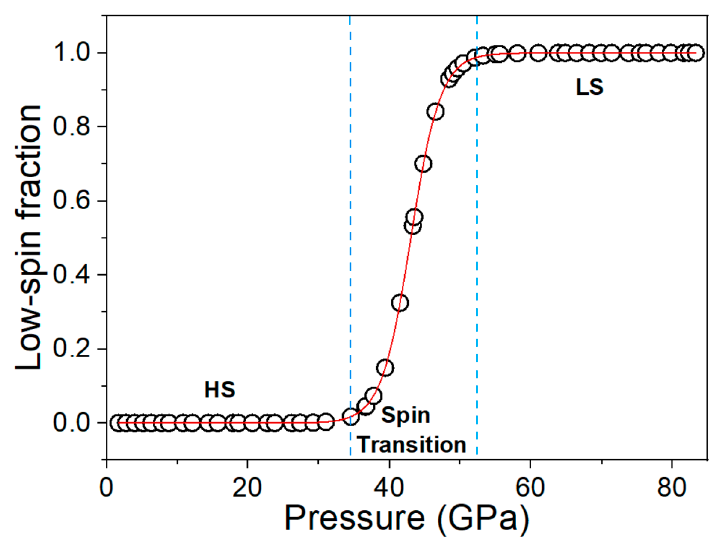
Figure 3. The low-spin fraction of siderite as a function of pressure with the use of NaCl as a pressure-transmitting medium. The low-spin fraction changes dramatically at around 38 to 48 GPa, corresponding to the spin crossover of siderite.